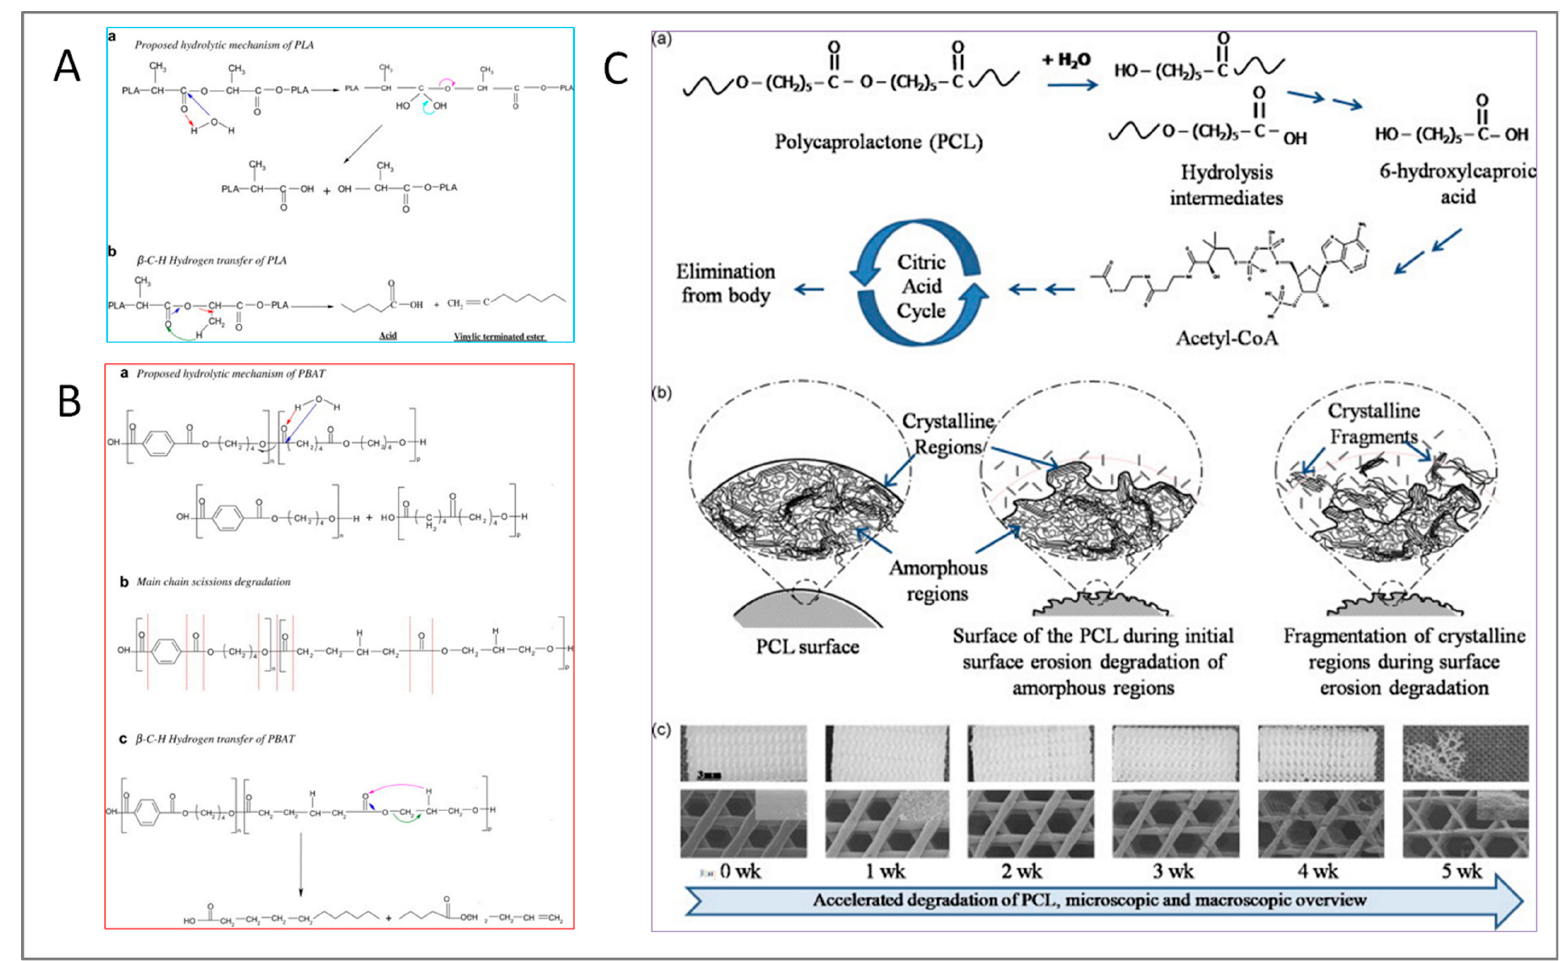
Figure 1. Schematics of hydrolytic degradation mechanisms of the most widespread biodegradable polyesters: poly-lactic acid (PLA) ( A ), poly-butylene adipate-co-terephthalate (PBAT) ( B ) [42], and poly-caprolactone (PCL) ( C ) [43] (reproduced with permission from Elsevier).